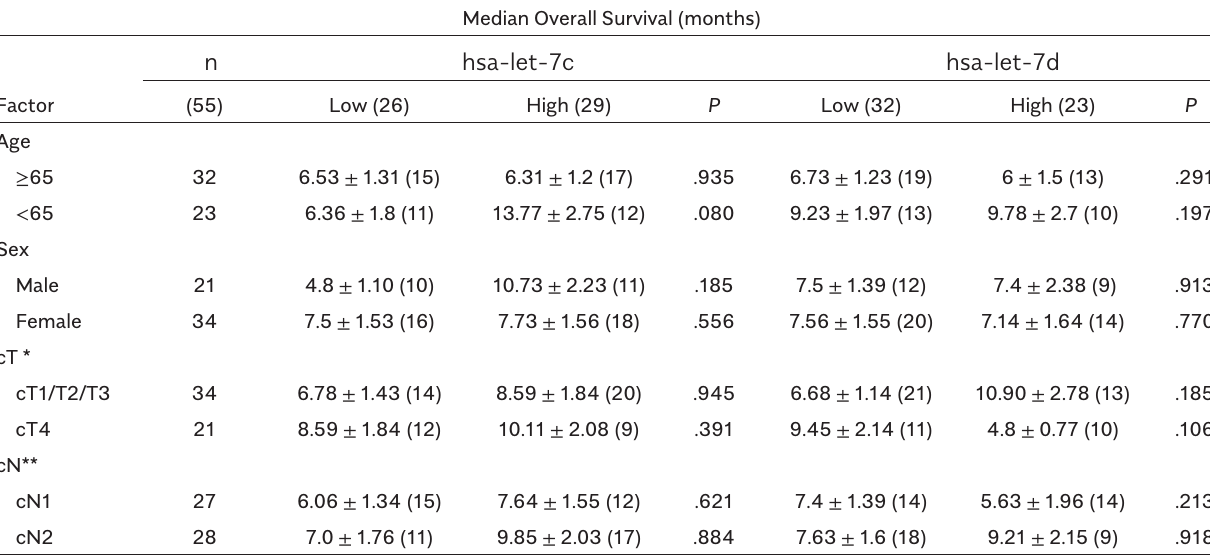
Table 2. The Relationship Between Median Overall Survival and Demographic and Clinical Findings in Serum High and Low Let-7c and Let-7d Level